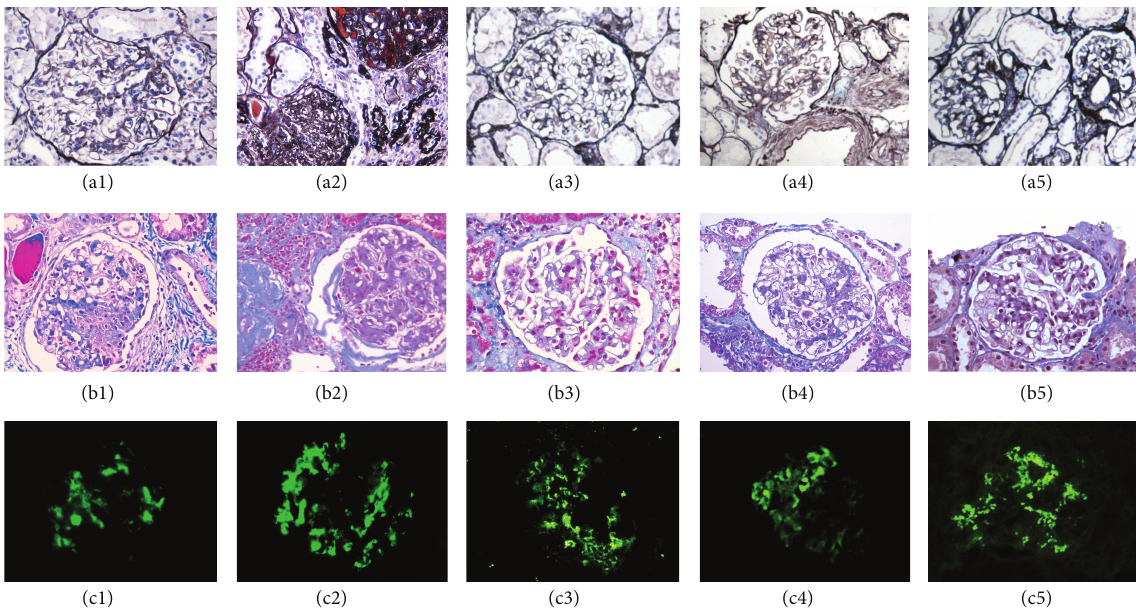
Figure 1: Light and immunofluorescent microscope findings of SLE that has nephritis with mainly IgA deposits. (a1), (a2), (a3), (a4), and (a5), respectively,indicatePASMstainingofcases1 ∼ 5underlightmicroscope( × 400).(b1),(b2),(b3),(b4),and(b5),respectively,indicateMASSON staining of cases 1 ∼ 5 under light microscope ( × 400). Hyperplasia of glomerular mesangium and matrix can be seen in all cases. In addition, case 2 has clear glomerular sclerosis. (c1), (c2), (c3), (c4), and (c5), respectively, indicate IgA deposits of cases 1 ∼ 5 under immunofluorescence microscope and all cases are positive (++ ∼